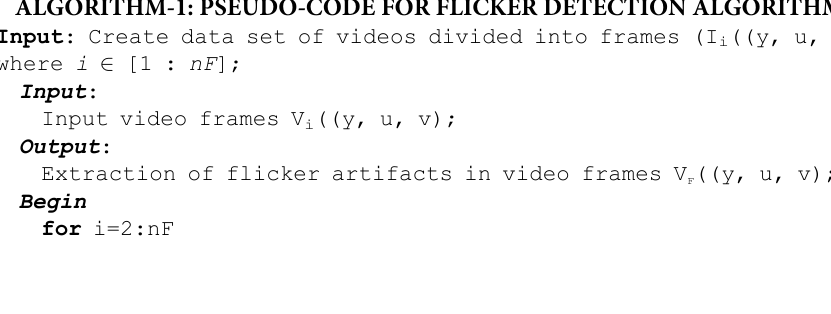
ALGORITHM-1: PSEUDO-CODE FOR FLICKER DETECTION ALGORITHM